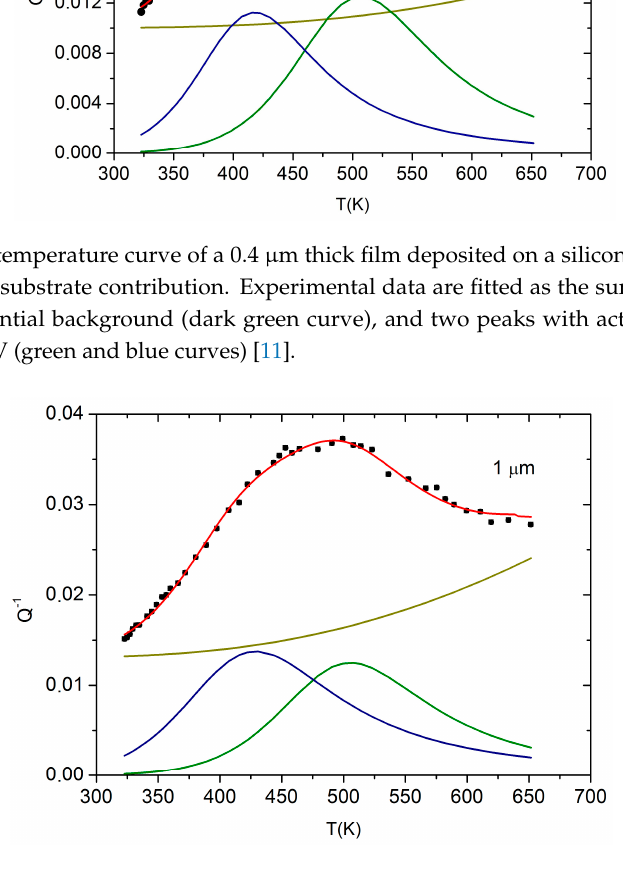
Figure 5. Q − 1 vs. temperature curve of a 1 µm thick film deposited on a silicon substrate after the subtraction of the substrate contribution. Experimental data are fitted as the sum (red curve) of an increasing exponential background (dark green curve), and two peaks with activation energies of 0.51 eV and 0.56 eV (green and blue curves) [11].